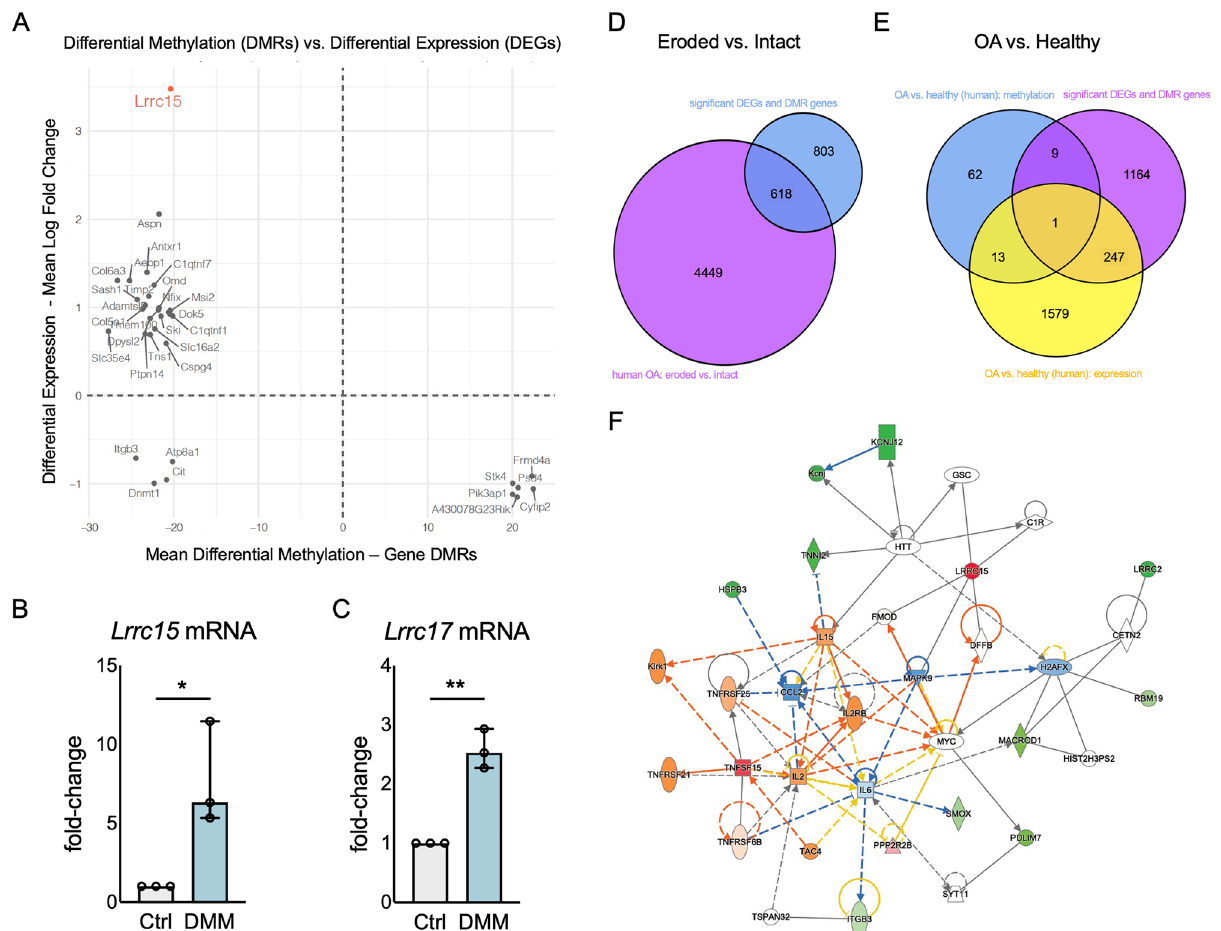
Figure 3. Lrrc15 is differentially methylated and differentially expressed in mouse OA cartilage. ( A ) Co-representation of differential expression (y axis, shown as mean Log Fold Change) and differential methylation (x axis, shown as mean differential methylation in gene associated DMRs) of genes with significant differential expression and methylation at 4 and 12 weeks. Lrrc15 is highlighted in red as the gene with the highest correlation between increased expression and reduced 5mC at 4 weeks. RTqPCR analyses of ( B ) Lrrc15 and ( C ) Lrrc17 mRNA in mouse cartilage samples at 4 weeks after surgical induction of OA (n = 3/ea). Data are shown as fold-change vs. controls (set as 1). *p < 0.05 by t-test. Venn diagram depicting unique and overlapping differentially expressed genes (DEGs) and differentially methylated regions (DMRs) obtained from our dataset using microdissected cartilage after DMM and published human datasets from human OA cartilage using ( D ) structurally intact and eroded cartilage and ( E ) healthy and OA cartilage samples. ( F ) Network analyses representing the interaction of Lrrc15 with other genes with differential methylation and expression at 4 weeks after surgical induction of OA. Circles indicate complexes or groups; squares indicate cytokines; diamonds represent enzymes; vertical ovals indicate transmembrane receptors; horizontal ovals indicate transcription regulators. A solid line connecting molecules indicates a direct interaction, and dotted lines indicate indirect interactions. Genes coloured in red are significantly overexpressed and in green are significantly underexpressed. A sub-pathway for upstream and downstream activity prediction is also highlighted, where orange is predicted activation and blue is predicted inhibition. A detailed legend for molecule shapes and interaction is available at https:// qiagen. secure. force. com/ Knowl edgeB ase/ artic les/ Basic_ Techn ical_Q_ A/